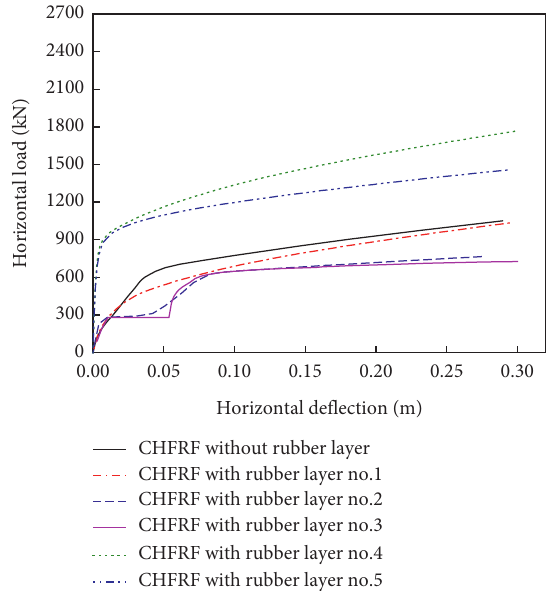
Figure 18: Effects of rubber layer on the lateral bearing